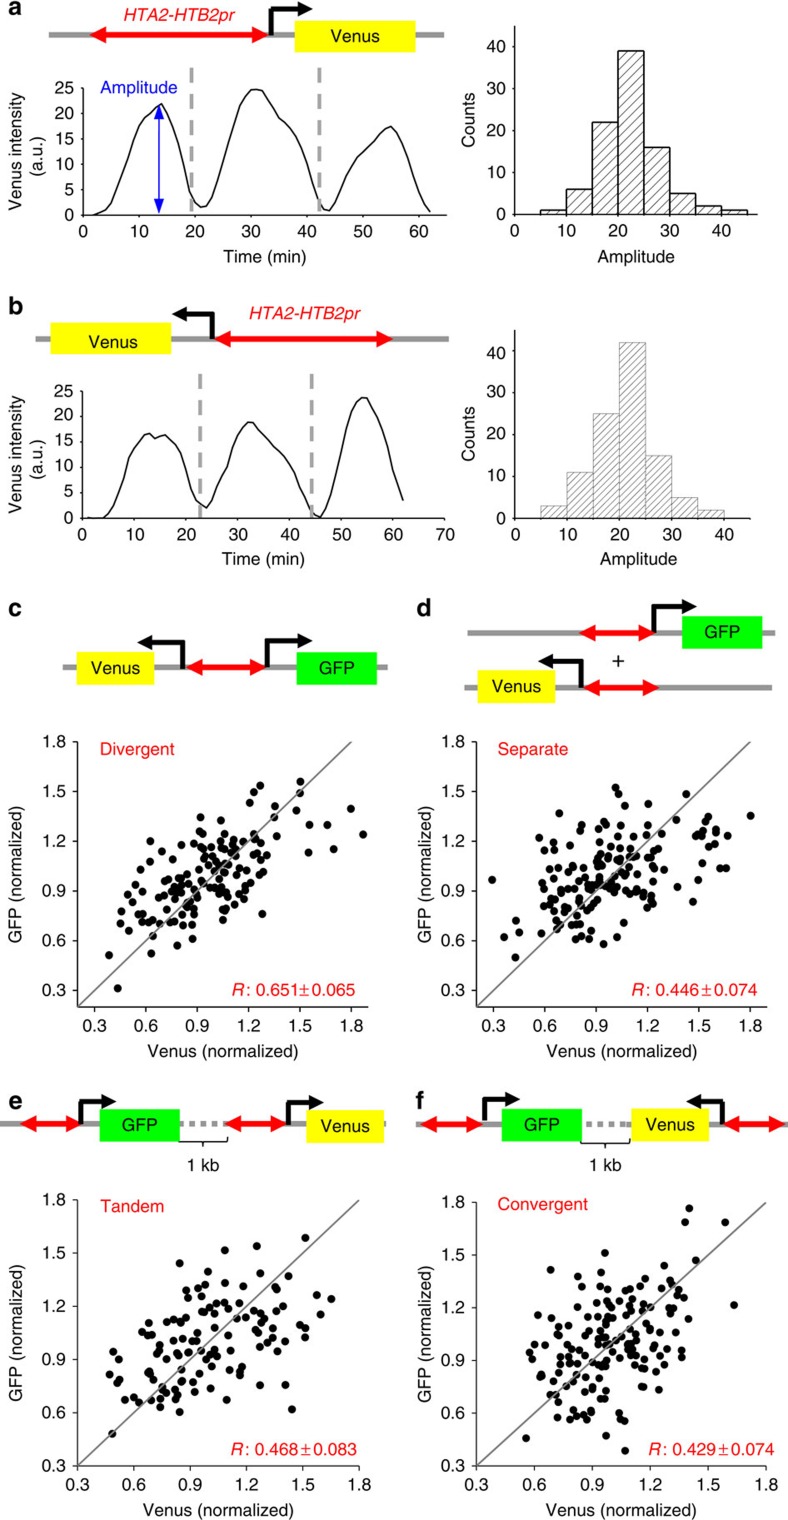
HTA2–HTB2 DGP enhances expression covariance.(a,b) Characterization of the cell cycle regulated activity of the HTA2–HTB2 promoter. The traces represent the Venus intensity as a function of time driven by this promoter from either orientation. The grey vertical lines indicate the time of cell division. The histograms of the cell cycle amplitudes, calculated as the peak-to-trough difference in the Venus signal per cell cycle, are also shown. a.u.: arbitrary unit. (c–f) Covariance between the GFP and Venus expression driven by the HTA2–HTB2 promoter in divergent (c), separate (d), tandem (e) or convergent (f) configurations. The x and y axis for each dot in these plots correspond to the normalized Venus and GFP amplitudes in the same cell cycle. The R values are Pearson correlation coefficient (mean±s.e.m.; see Methods). Number of cell cycles: divergent: 140; separate 149; tandem: 115; convergent: 150.